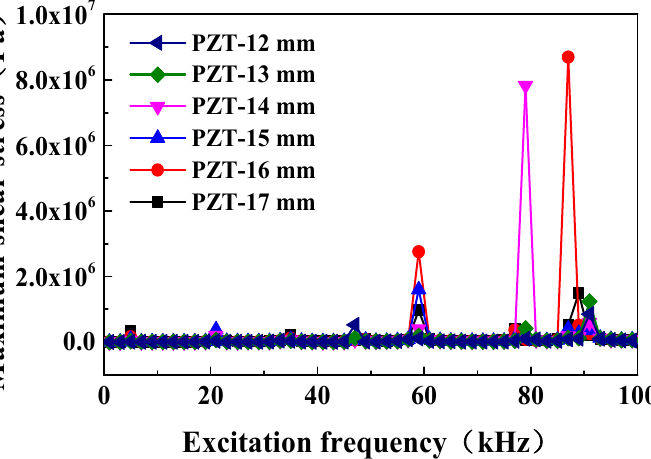
Figure 7. Variations in maximum shear stress with excitation frequency and the side length of the PZT patch. As shown in Figure 7, when the side length of the PZT patch is 16 mm × 16 mm or 14 mm × 14 mm, the maximum values of shear stress at the adhesive interface are high in both cases. Based on the existing research findings, the maximum adhesive shear stress of ice covering on metal substrates is about 1.8 × 10 6 Pa [22]. Therefore, in the above simulation cases, there are three kinds of conditions satisfying the deicing condition. The parameters in these conditions and simulation results are listed in Table 2, and the cloud images of the distributions of shear stress at the adhesive interface under these conditions are shown in Figure 8. Table 2. Parameters and maximum shear stresses. Side Length of PZT